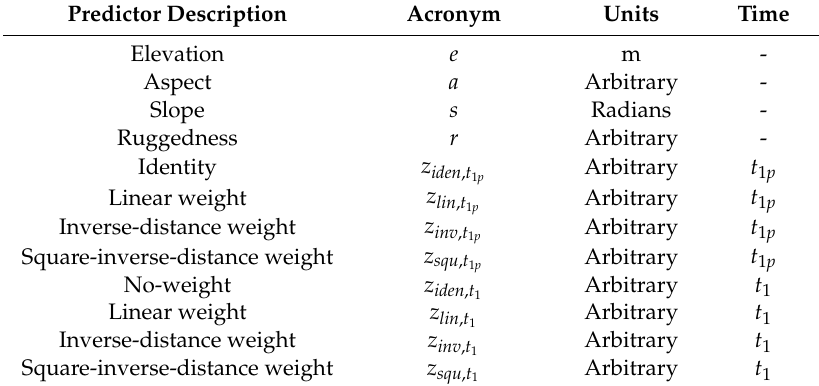
Table1. Listofpredictorvariablesusedformodeling. TheAcronymcolumnidentifiesthecorresponding variable in Equations (6) and (7). The Time column indicates whether the variable is calculated at t 1 p or t 1 (see text for an explanation). Predictor Description Acronym Units Time Elevation e m - Aspect a Arbitrary - Slope s Radians - Ruggedness r Arbitrary - Identity z iden , t Arbitrary t 1 p 1 p Arbitrary t 1 p Linear weight z lin , t 1 p Inverse-distance weight z inv , t Arbitrary t 1 p 1 p Square-inverse-distance weight z squ , t Arbitrary t 1 p 1 p Arbitrary t 1 No-weight z iden , t 1 Linear weight z lin , t Arbitrary t 1 1 Inverse-distance weight z inv , t Arbitrary t 1 1 Square-inverse-distance weight z squ , t Arbitrary t 1